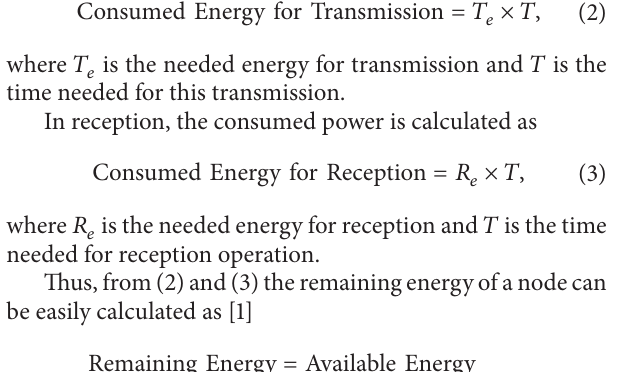
Figure 3: Announcing remaining